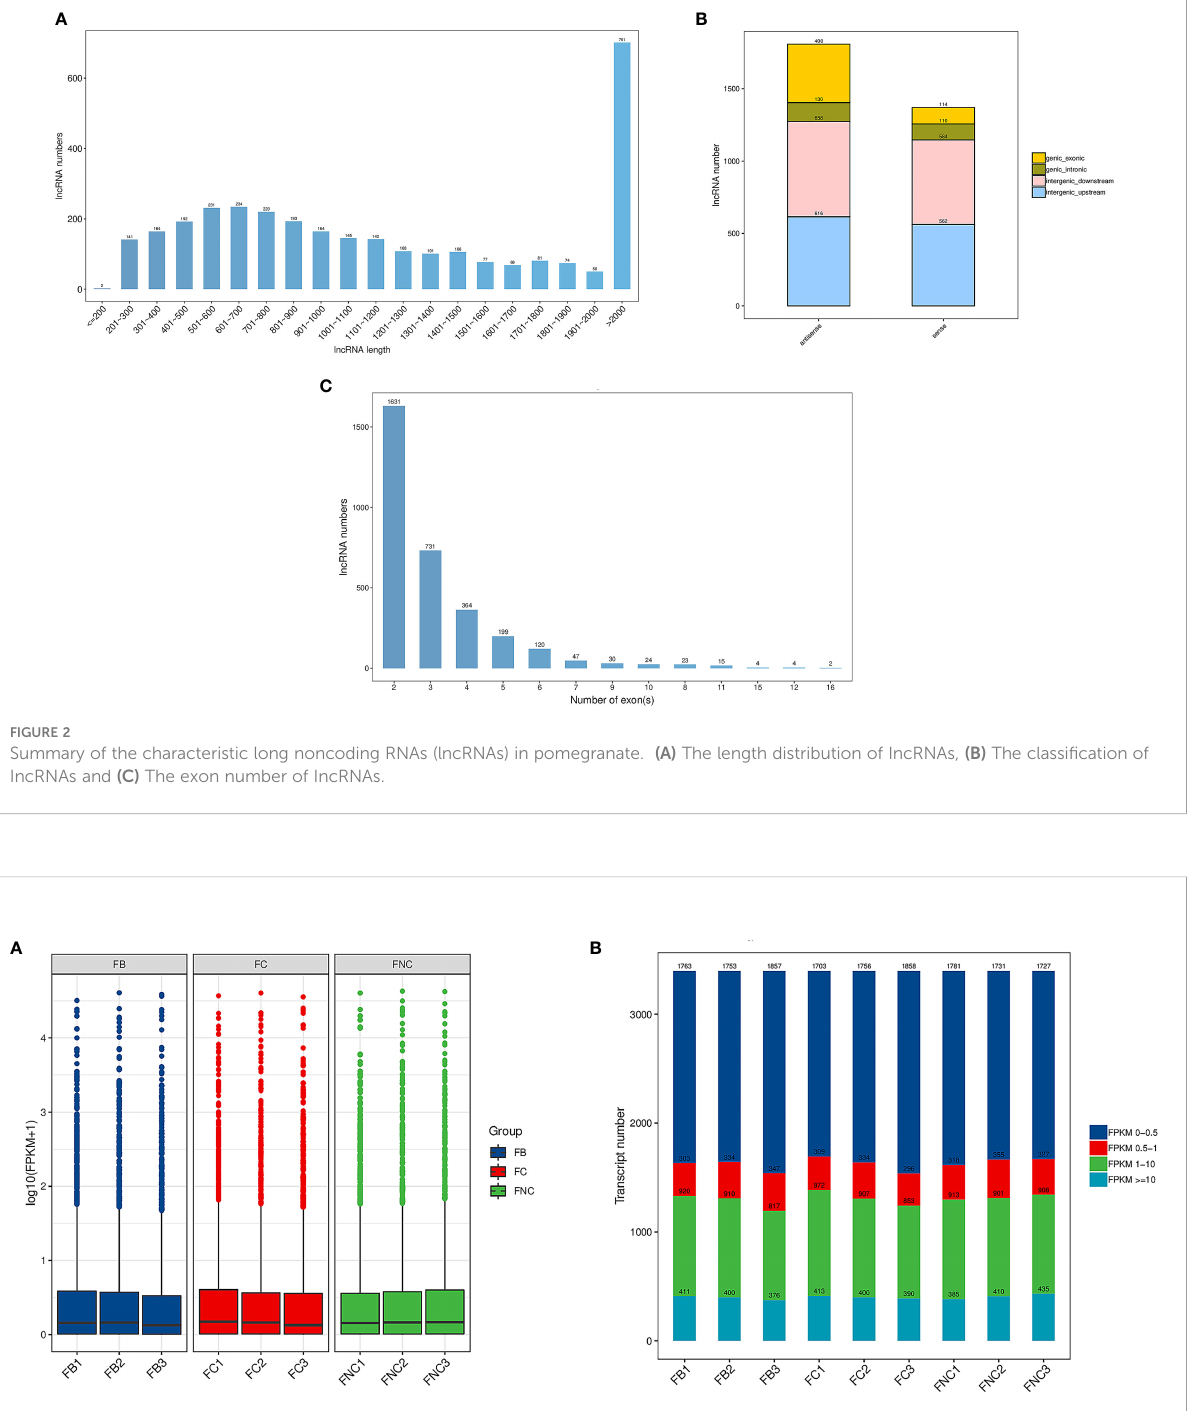
FIGURE 3 Long noncoding RNAs (lncRNAs) expression level analysis in pomegranate. (A) Boxplot of fragments per kilobase per million reads (FPKM) values. (B) Transcript expression b.